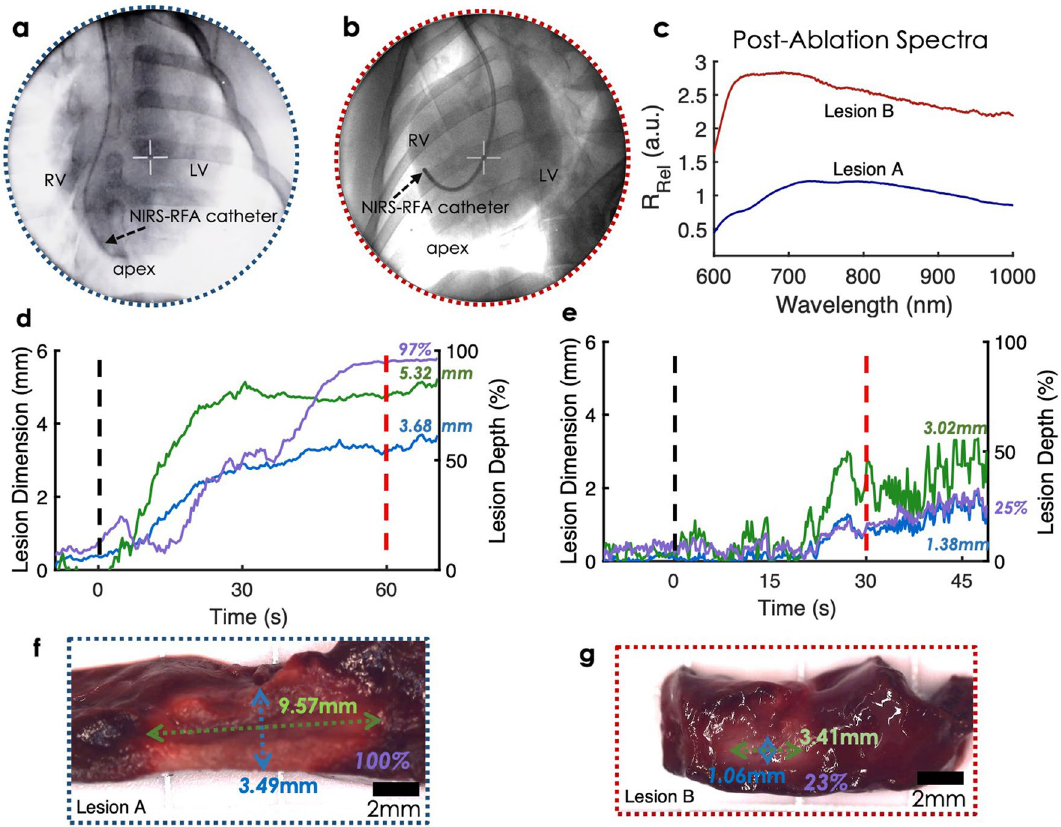
Figure 7. In vivo NIRS assessment of endocardial lesion delivery in pigs. Example measurements are shown for two cases: a transmural (Lesion A) and non-transmural (Lesion B) case. ( a , b ) Shows percutaneous navigation of the NIRS-RFA catheter under fluoroscopic guidance for lesion delivery near the apex (Lesion A) and at the RV free wall (Lesion B), respectively. ( c ) Shows final R Rel spectra measured following the NIRS acquisition of lesion delivery. ( d , e ) Depicts time courses of gaussian process regression model predictions derived from final R Rel spectra for both lesions. Black and red dashes denote the onset and completion. ( f , g ) Show corresponding TTC stained cross-sections annotated with actual lesion